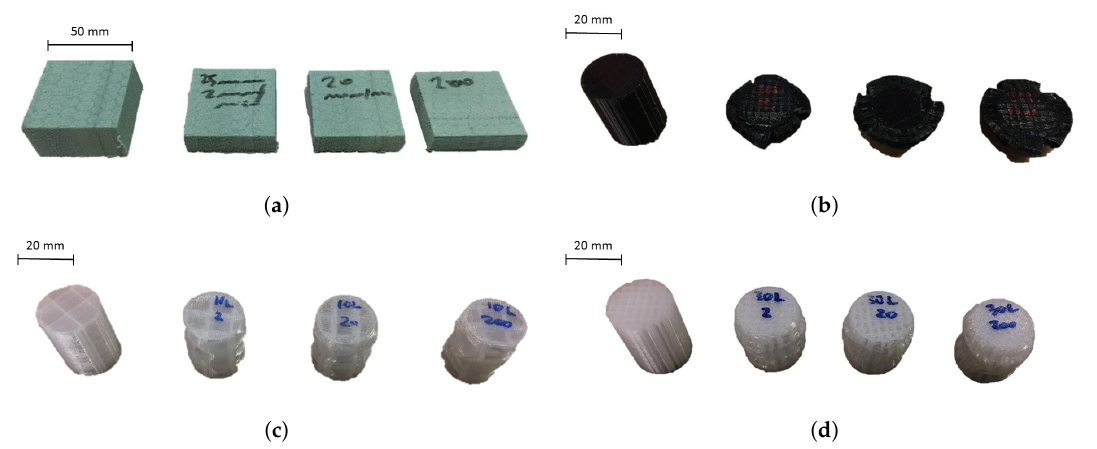
Figure 6. Representative specimens tested under quasi-static conditions. From left to right: pristine, 2 mm/min, 20 mm/min and 200 mm/min. ( a ) Type I (PET); ( b ) Type AH (3D printed PLA); ( c ) Type AC (3D printed PA); ( d ) Type AD (3D printed